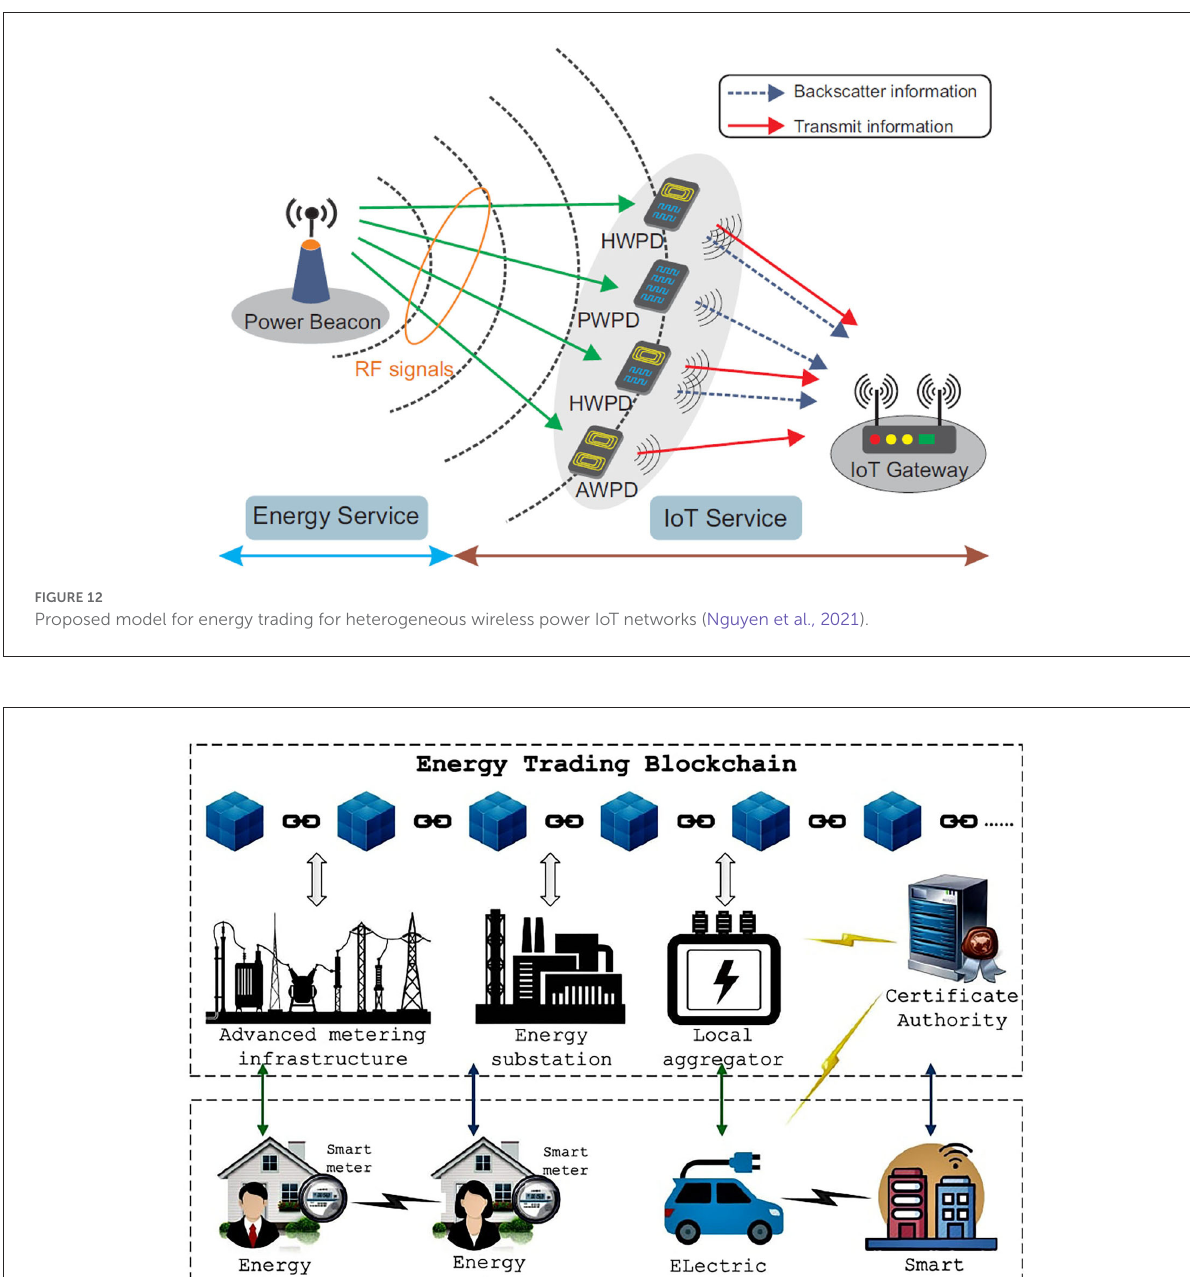
energy trading. The main factor contributing to the overall cost is the cost of mining the blockchain and defines the workflow of each miner of the blockchain network.